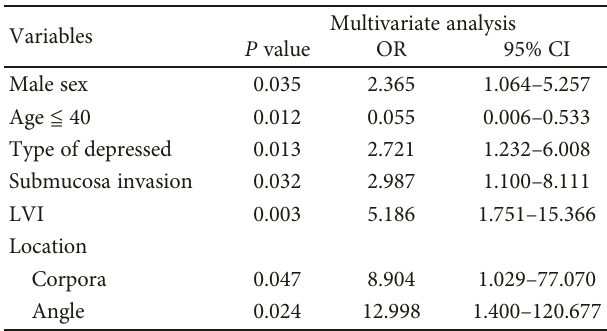
Table 4: Multivariate logistic regression analyses for lymph node metastasis of early gastric